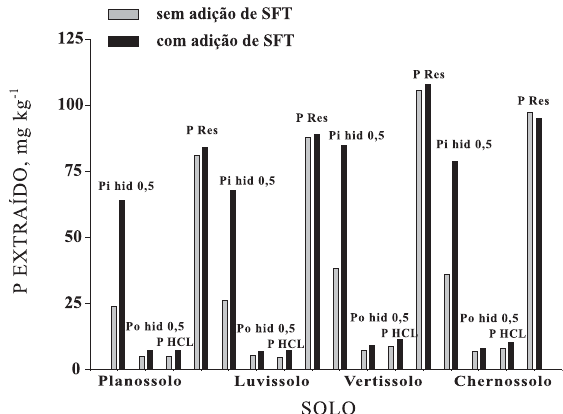
Figura 2. Teores de fósforo nas frações de amostras do Planossolo, Luvissolo, Vertissolo e Chernossolo sem e com a adição de fósforo (SFT). Pi-hid 0,5: Pi-hidróxido 0,5 mol L -1 ; Po-hid 0,5: Po-hidróxido 0,5 mol L -1 ; P-HCl; P-Res: P